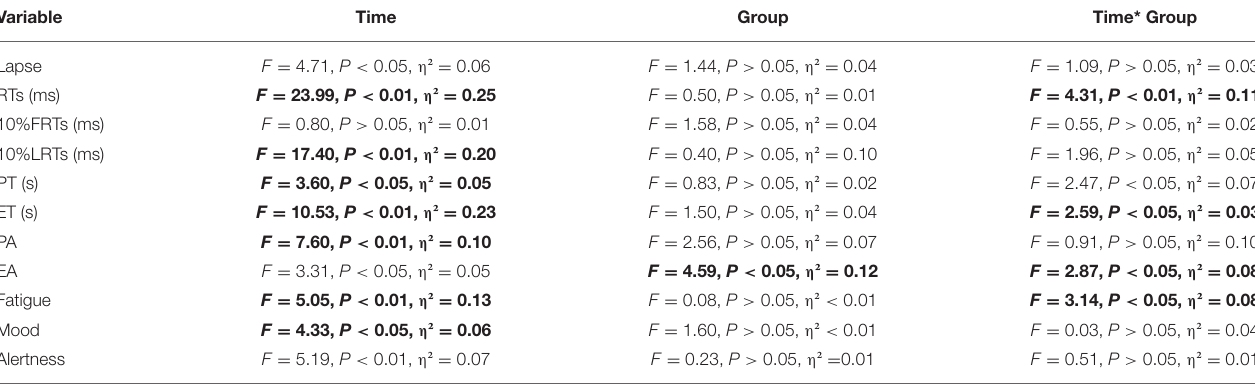
TABLE 2 | Results of ANOVA for measurements. Variable